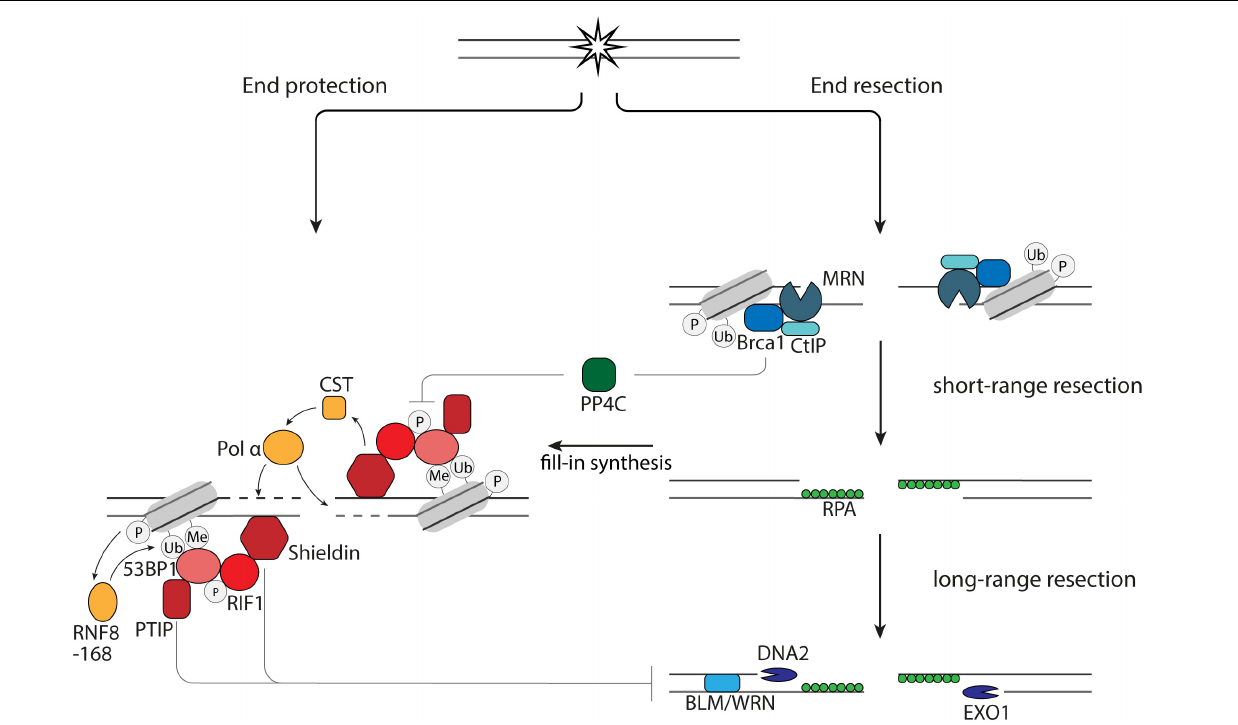
FIGURE 1 | End resection versus end protection. 53BP1 protects DNA ends via its effector proteins, PTIP, RIF1, and Shieldin via (1) inhibition of EXO1 and DNA2 and (2) fill-in synthesis by the CST-Pol α . End protection is counteracted by BRCA1 via dephosphorylation of 53BP1 by